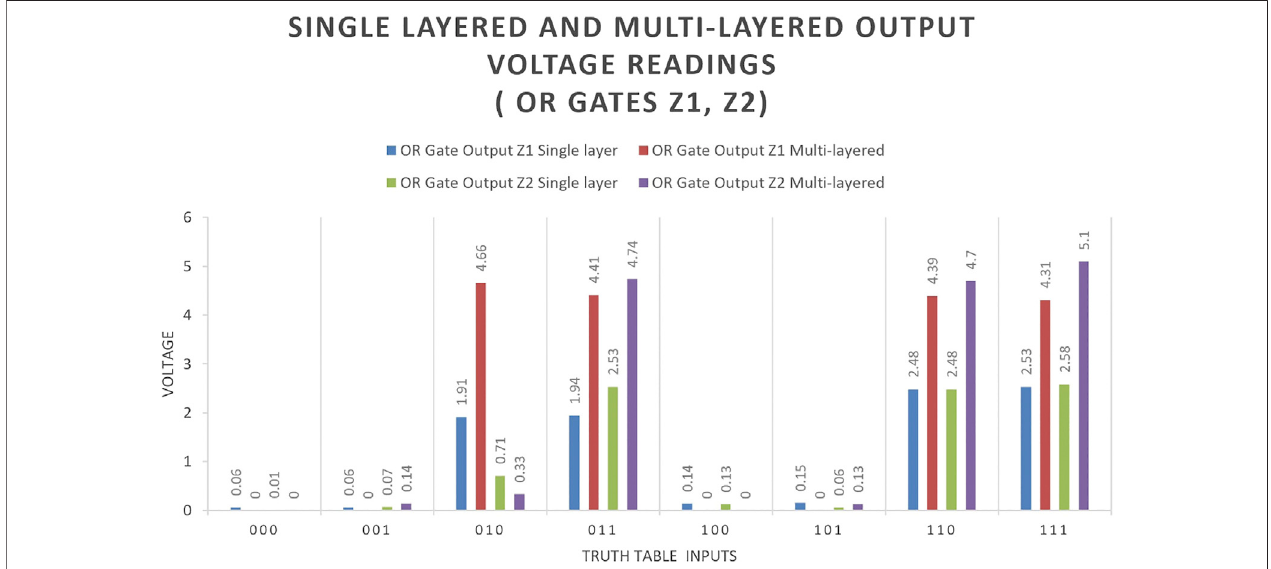
FIGURE 11 | OR gate outputs Z1 and Z2 for single-layer vs. multilayer PLA